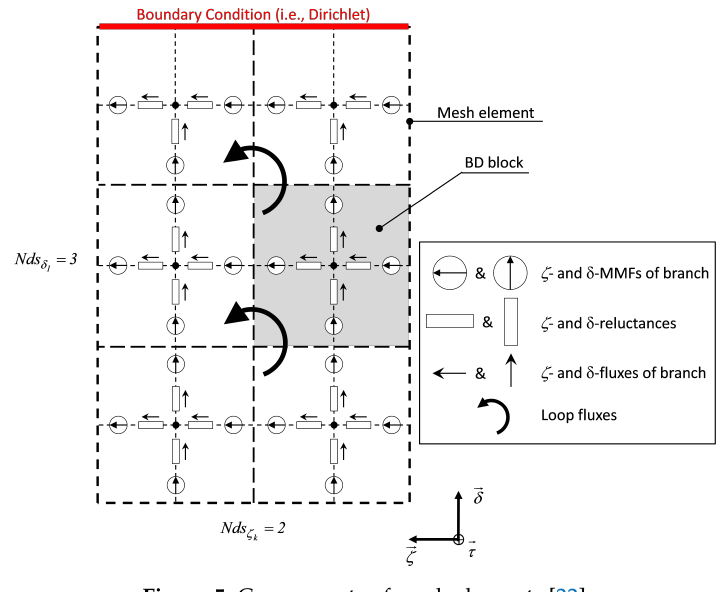
Figure 5. Components of mesh elements [22].